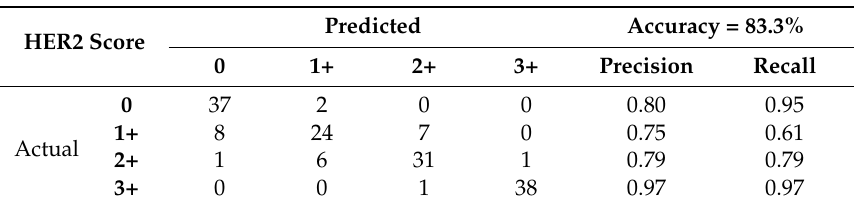
Table 5. Confusion matrix for the multi-class logistic regression algorithm with the reduced feature set. Reproduced from [12] with permission.